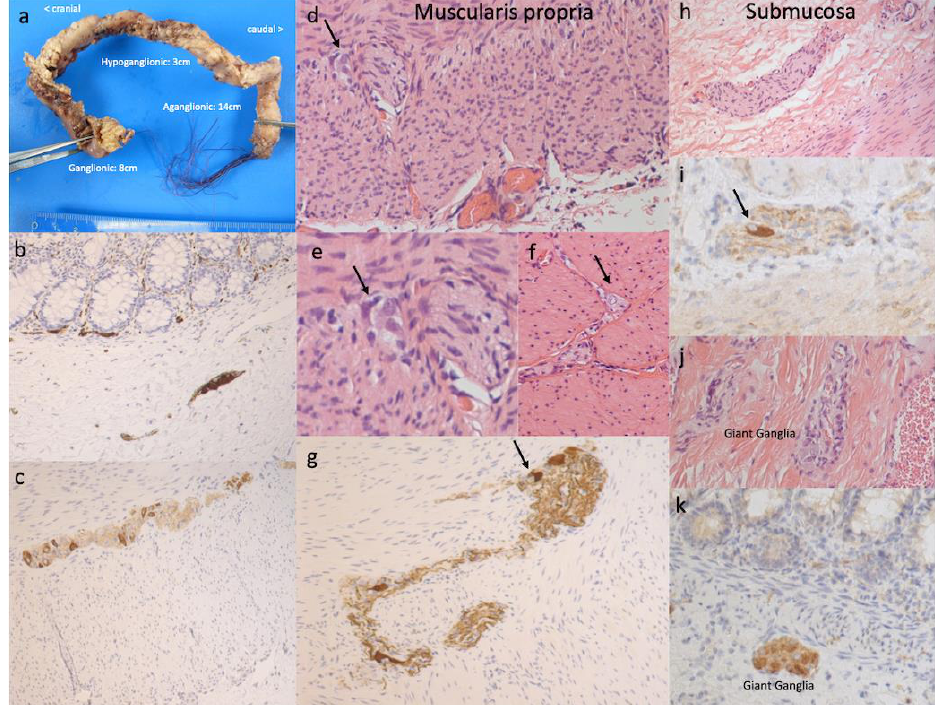
Figure 2. Pathomorphological aspects of the transition zone: ( a ) full specimen ( b ) and ( c ) ganglia in the submucosa and muscularis propria in normal colon stained with Calretinin or RET1. ( d ) Reduced number of ganglia in the muscularis propria ( e ) and ( f ) focal, irregular residual ganglia cells. ( g ) Cal- retinin staining of reduced ganglia cells. ( h ) Multifocal accentuated hypoplasia of ganglia cells and thickening of nerve fibres. ( i ) Reduced/irregular residual ganglia cells ( j , k ) Giant ganglia